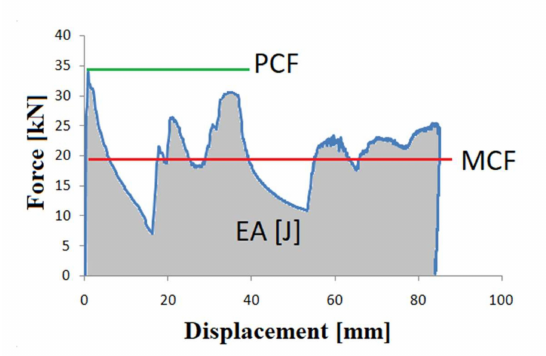
Figure 1. An exemplary force-displacement